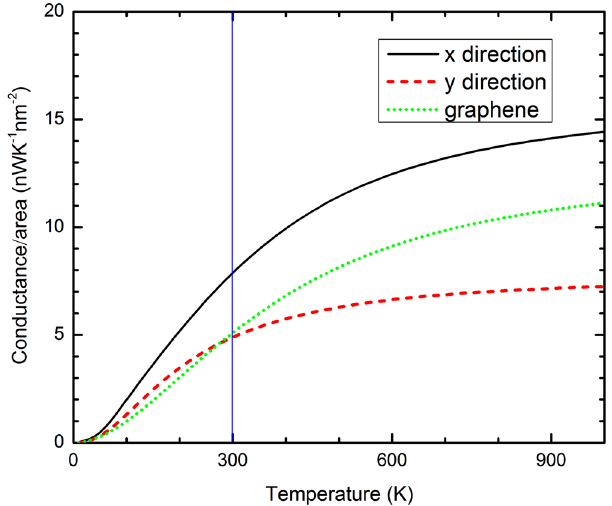
Fig. 2 Thermal conductance of hexagonal borophene. Variations of the thermal conductance per unit cross-sectional area of borophene with temperature in both x -direction and y -direction. The thermal conductance curve of graphene is also presented for comparison